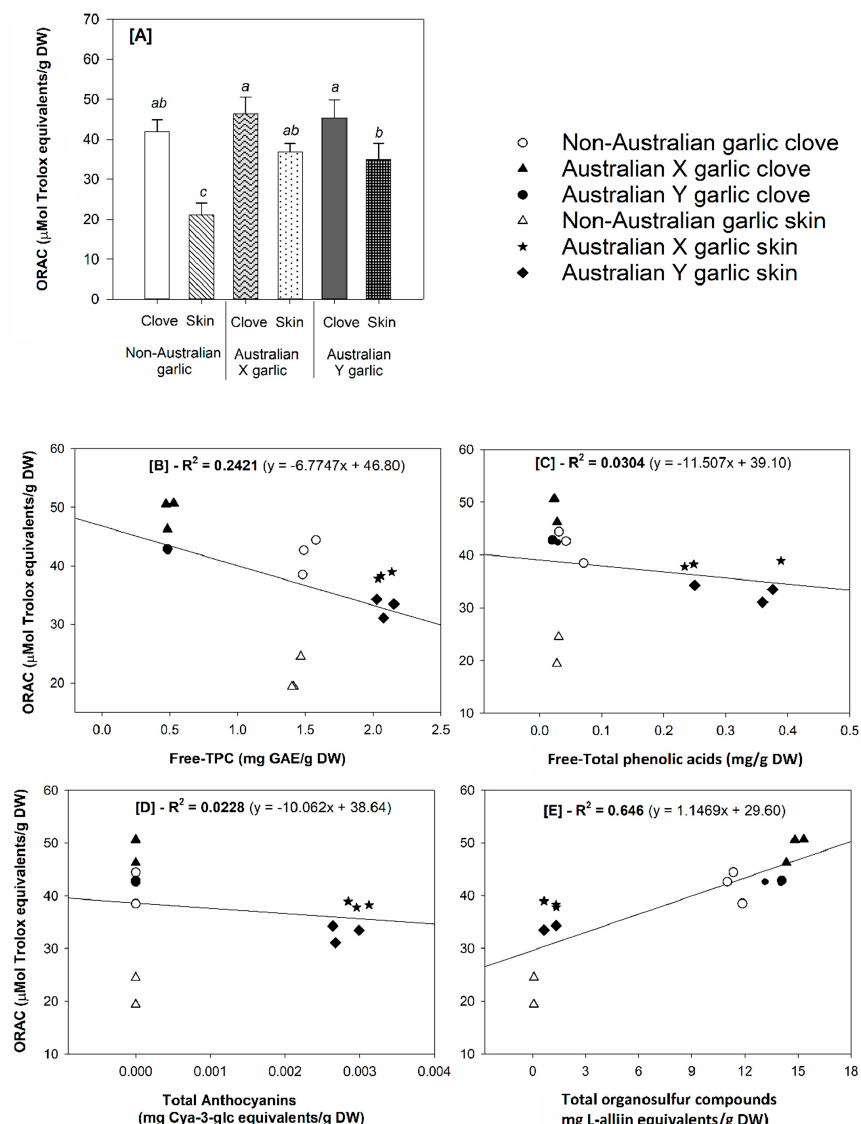
Figure 3. (A) Antioxidant capacity (Oxygen radical absorbance capacity—ORAC) and correlation between ORAC values and the determined (free) phytochemicals in the analyzed garlic samples: [B] ORAC vs. free total phenolic content (TPC), [C] ORAC vs. free total phenolic acids, [D] ORAC vs. total anthocyanins, and [E] ORAC vs. total organosulfur compounds. Different letters in Figure A indicate significant differences in antioxidant capacity among the samples tested at α = 0.05 ( n = 3).